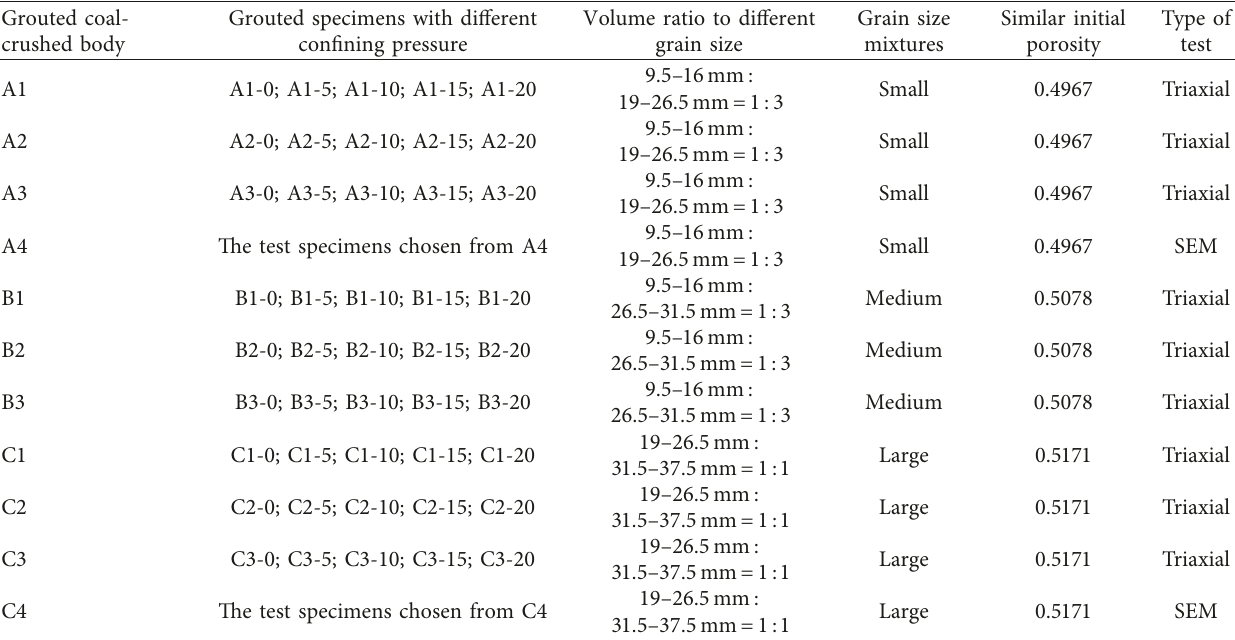
Table 2: Grouted specimens with different grain size distributions used in this research.